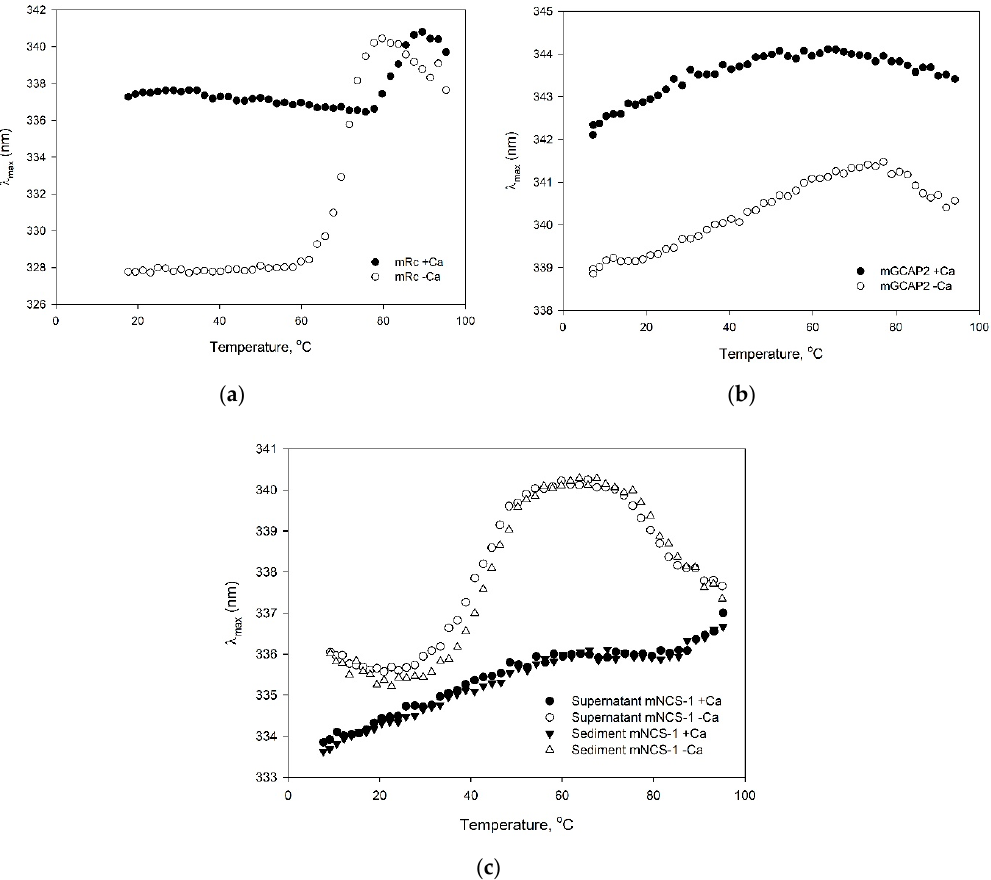
Figure 6. Thermal denaturation of apo- (1 mM EGTA, open circles) and Ca 2 + -bound (1 mM CaCl 2 , solid circles) forms of the purified myristoylated NCS proteins (4.8 μ M), monitored by their tryptophan fluorescence ( λ max , fluorescence spectrum maximum position): recoverin ( a ), GCAP2 ( b ) and NCS-1 purified from either soluble or insoluble fractions ( c ). Excitation wavelength was 280 nm.